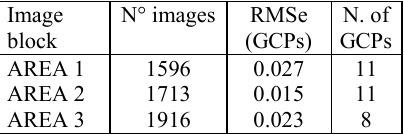
Table 3. Processing Strategy 1, main parameters of the processing of the three blocks.